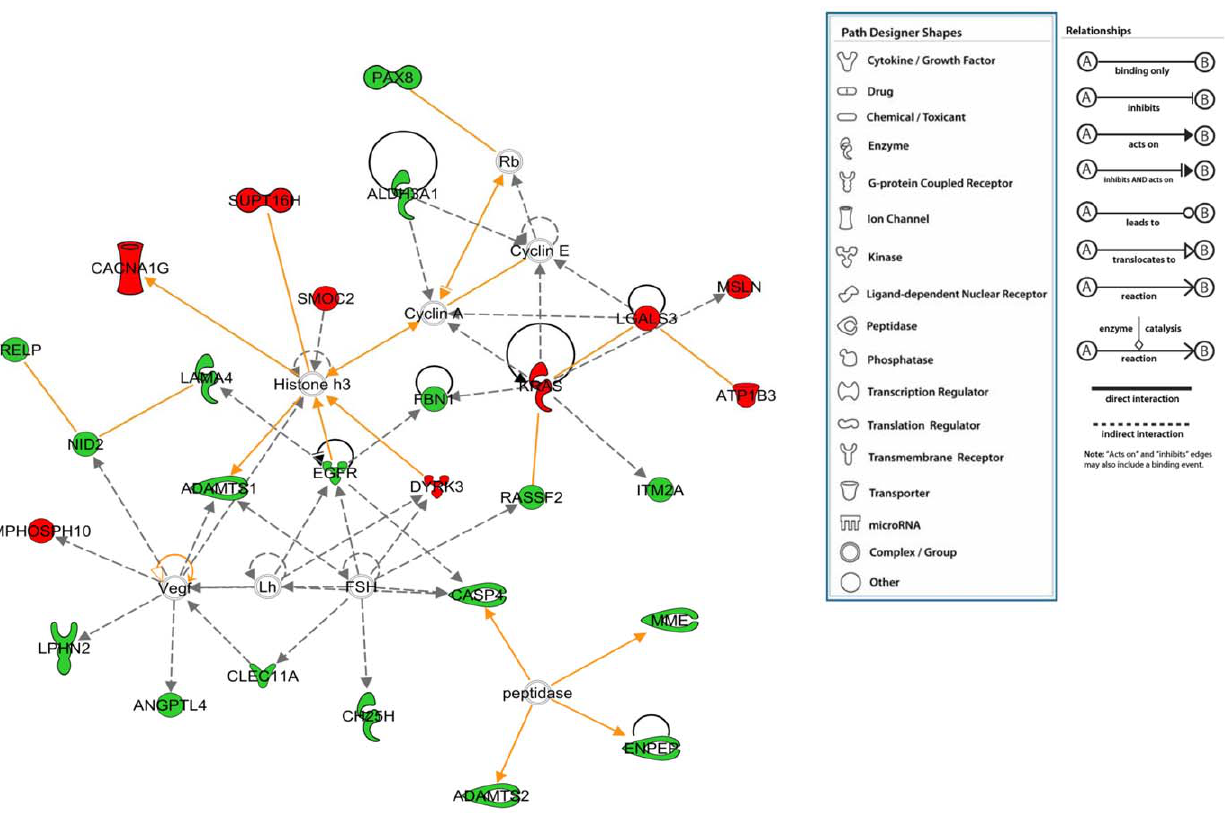
Figure 10. The genes differentially regulated ( p -value , 0.05 and fold change $ ± 2.0) between the P53 knock out and the P53 knock out with Mta1 over expressed MEFs ( Mta1 regulated genes independent of P53 ) were subjected to the network analysis and the most significant network found is associated with cancer and genetic disorders. Most of the genes in the network were found to be down regulated in P53 -KO/ Mta1 when compared with P53 -KO. All the upregulated genes are shown in red and the down regulated genes are shown in green color.